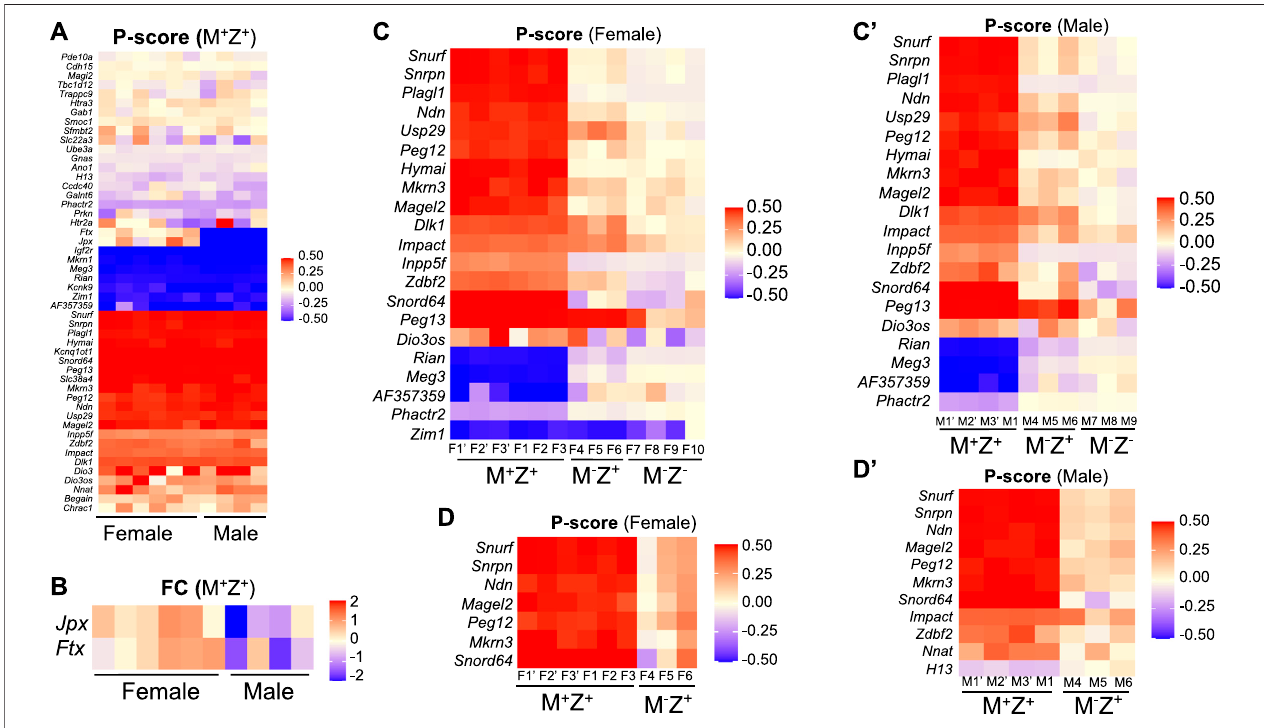
embryos of the M + Z + , M − Z + , and M − Z - genotypes. P-score was calculated for assessing the proportion of the transcripts derived from the paternal allele of each imprinted gene carrying an SNP, and the intensity difference heatmaps were plotted accordingly ranging from 0.5 (red, paternal allele only) to − 0.5 (blue,